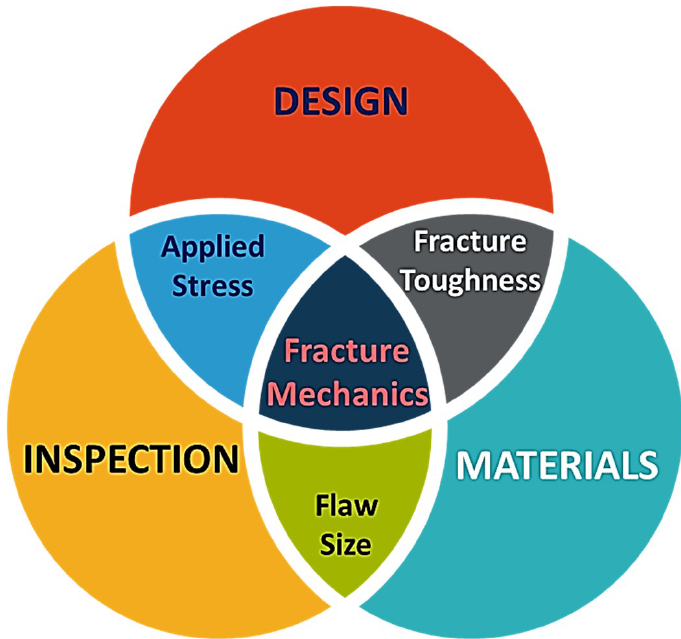
Figure 2. Picture depicting fracture mechanics as an integrated blend of applied stress, flaw size analysis, and fracture toughness.